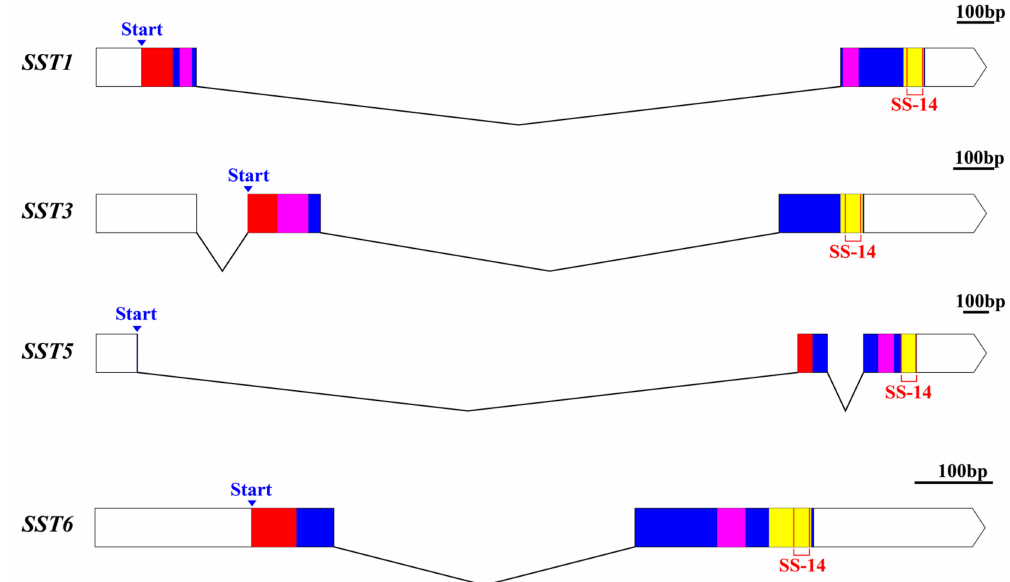
Figure 1. Schematic diagram of the exon–intron structure and protein domain prediction of SST genes in S. argus . The white rectangle on the left represents the 5’UTR and the white polygon on the right depicts the 3’UTR. The open reading frame is indicated by colored boxes. The blue arrows represent the start codon position, and signal peptides are marked in red, the low complexity and Pfam: Somatostatin regions are marked in purple and yellow, respectively. Regions encoding mature peptides are indicated by orange boxes. The short solid lines at the top right are scale bars, representing 100